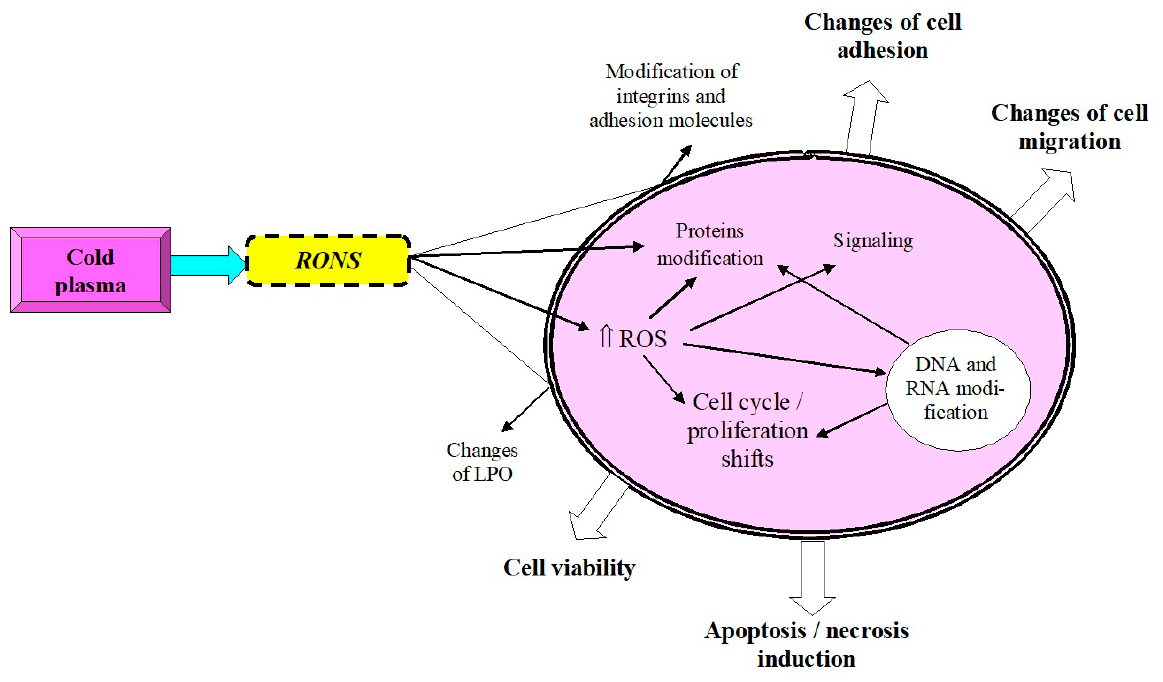
Figure 2. Cellular response to exposure to cold atmospheric plasma (RONS—reactive oxygen and nitrogen species, ROS—reactive oxygen species, LPO—lipid peroxidation).